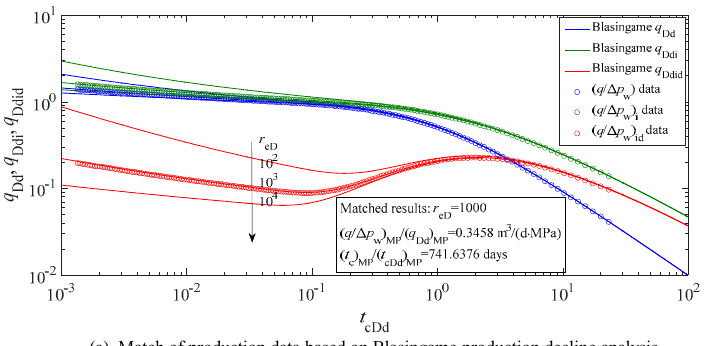
Figure 9. Match of production data for CPP case of